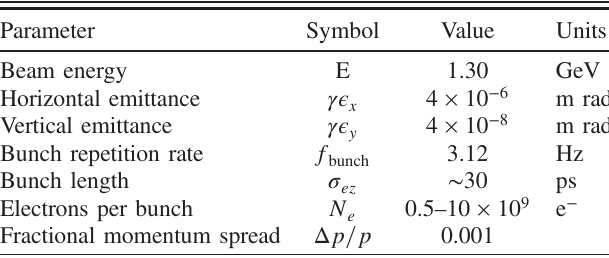
TABLE I. ATF2 parameters.